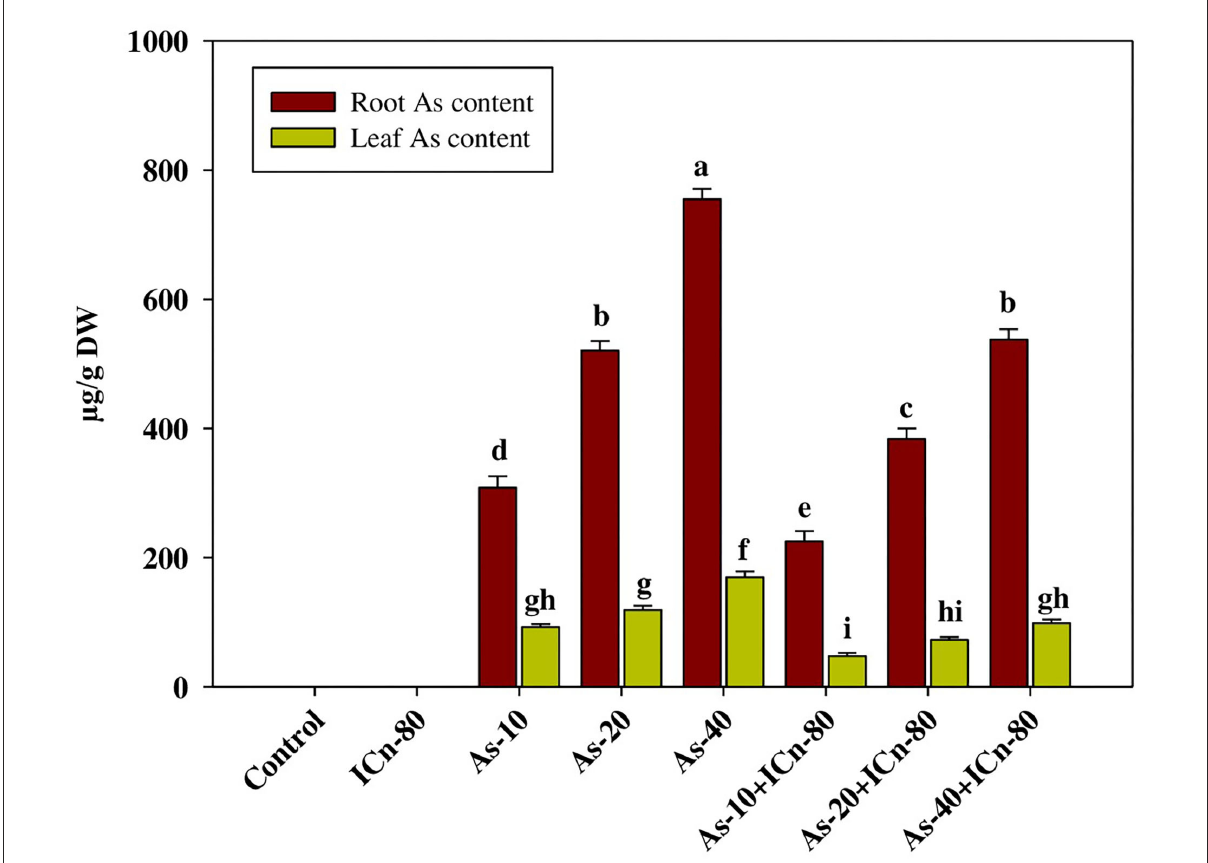
FIGURE2 Leaf and root arsenic accumulation of peppermint ( Mentha piperita L.) at 150 days after transplanting with/without As stress (10, 20, or 40mg kg − 1 of soil, as Na 2 HAsO 4 · 7H 2 O) and treated with ICn (80mg L − 1 ). Data are presented as treatment mean ± SE ( n = 5). Bars with the same letters are not significantly dissimilar ( P <